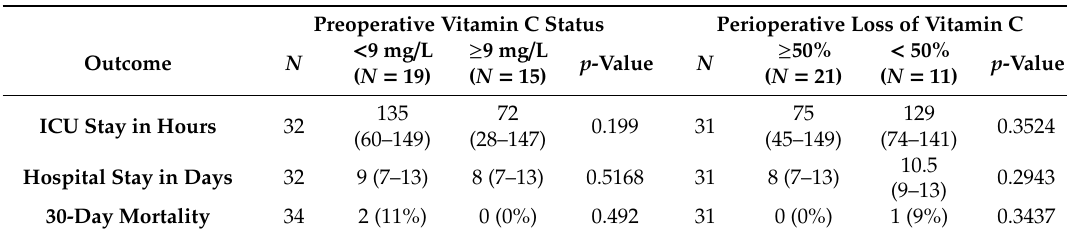
Table 5. Association of perioperative vitamin C levels with length-of-stay and mortality. N, number of patients, presented as median (interquartile range) or amount